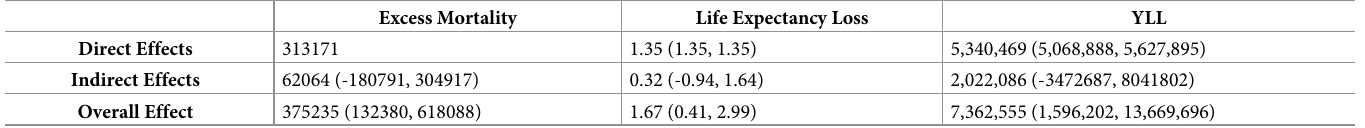
Table 3. Summary of the direct, indirect, and overall effects of the COVID-19 pandemic in the United States in 2020.